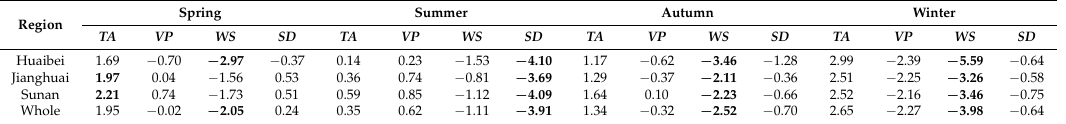
Table 4. Values of assessment index R for quantifying the contributions of climatic factors to the change trends of seasonal ET ref in each region of Jiangsu